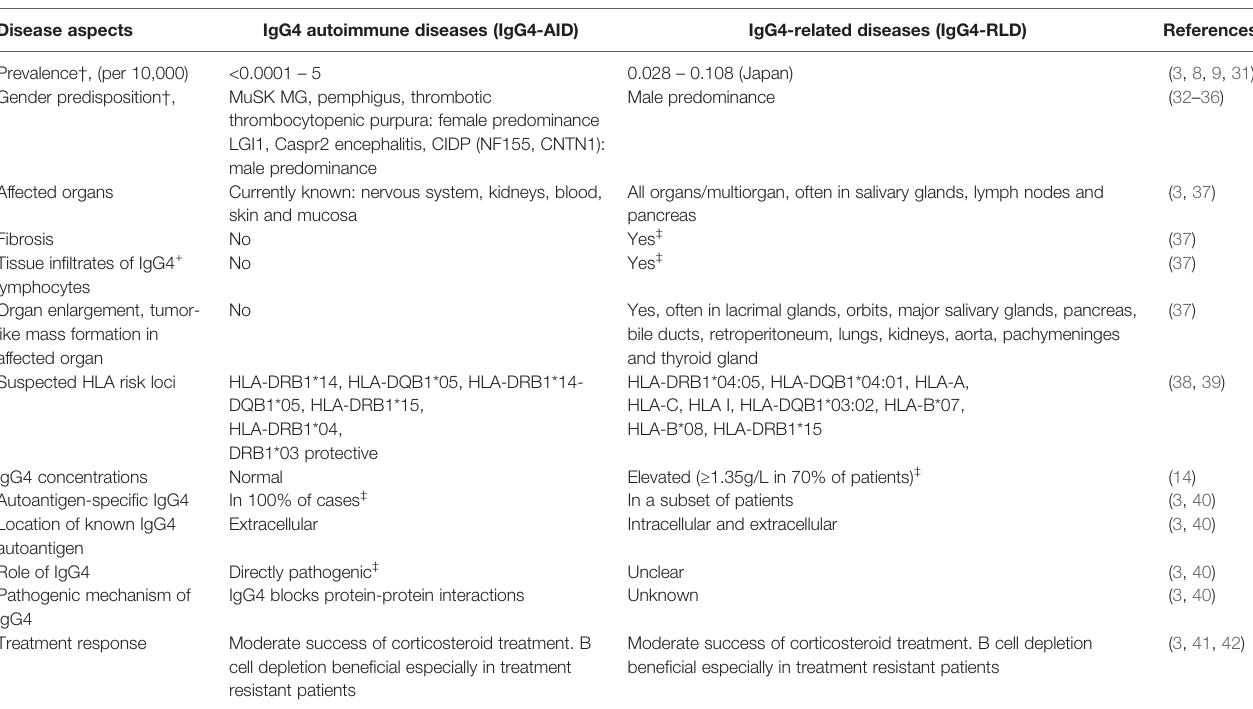
TABLE 2 | Summary of IgG4-AID vs.